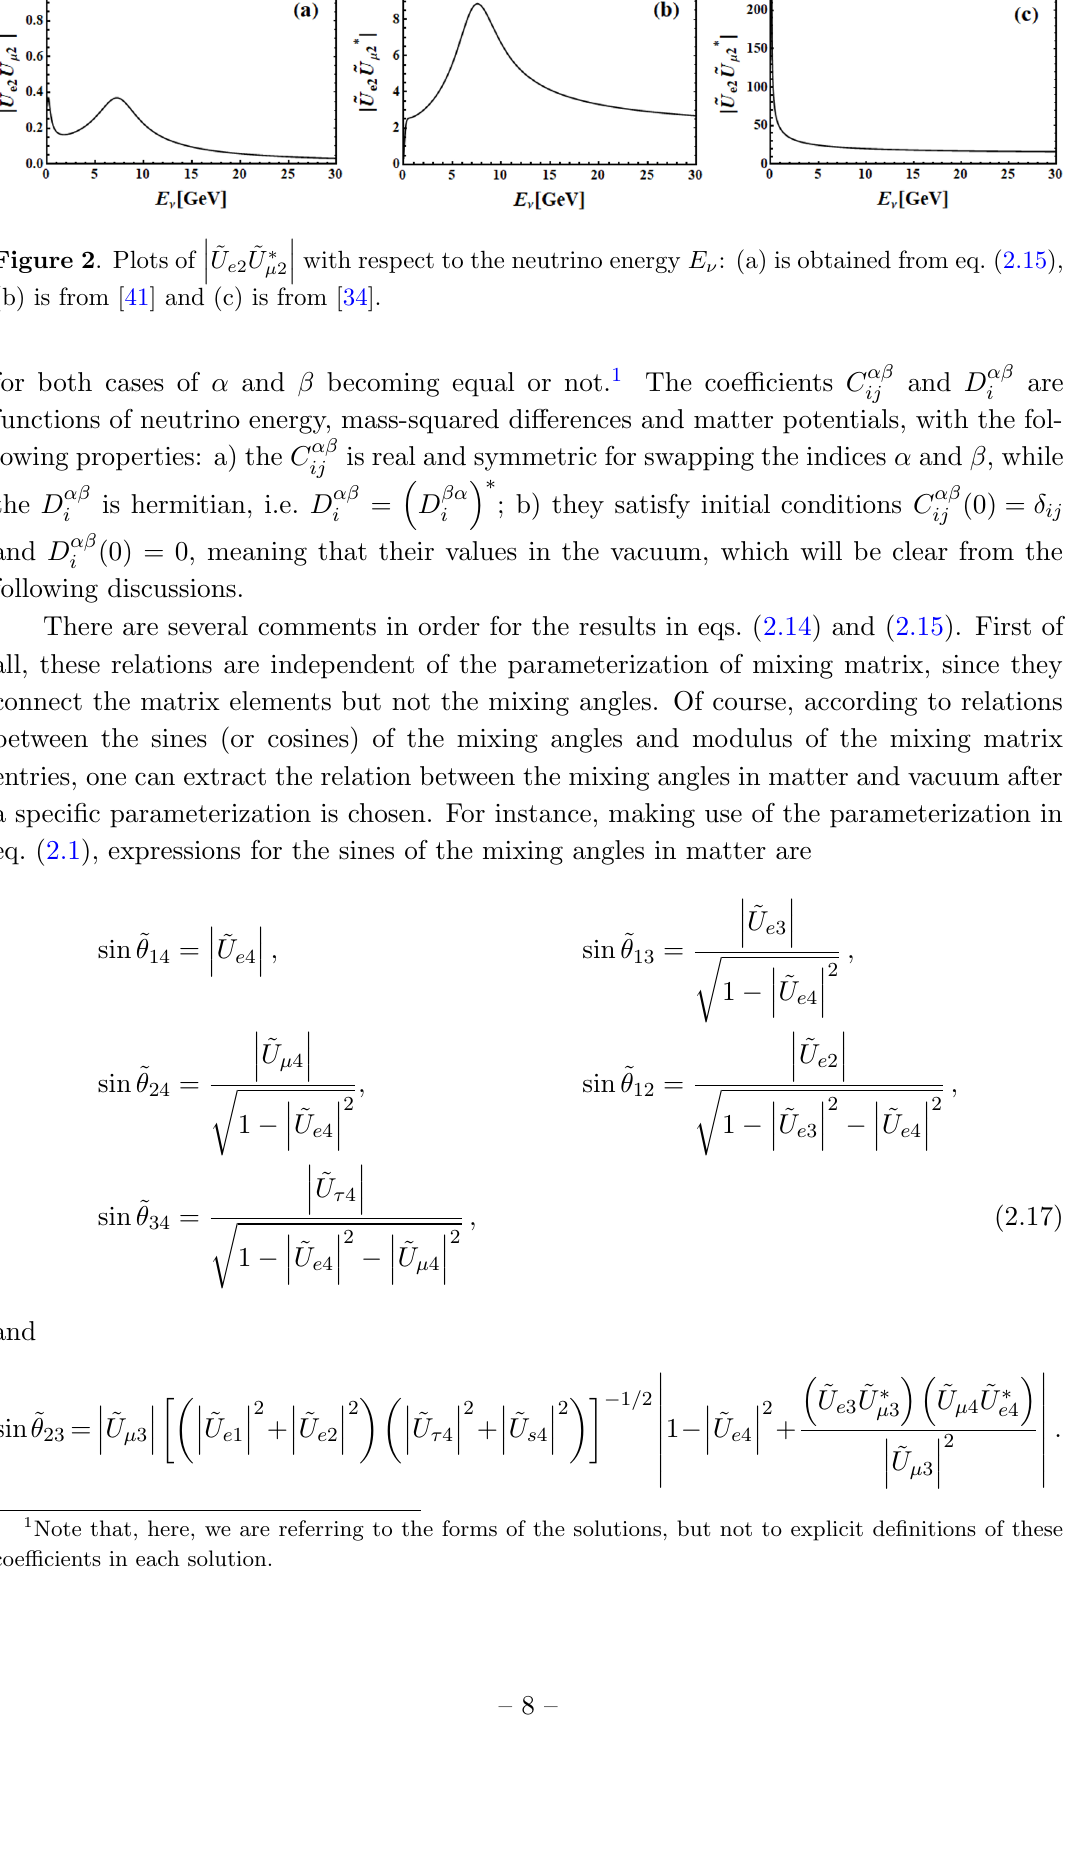
(cid:12) (cid:12) ~ U ~ U (cid:3) (cid:12) (cid:12) with respect to the neutrino energy E (cid:23) : (a) is obtained from eq. (2.15), e 2 (cid:12) (cid:12) (cid:22) 2